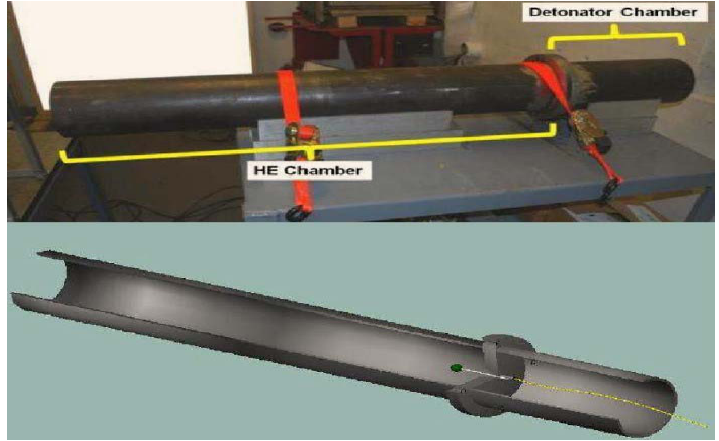
Figure 4: Laboratory Explosive Shock Pipe.